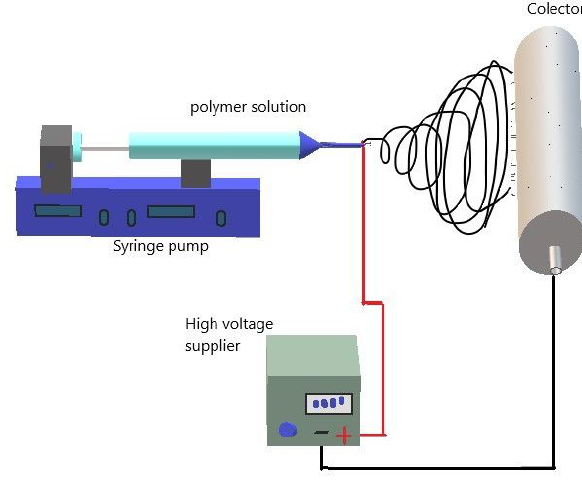
Figure 1: Schematic representation of basic electrospinning set up.